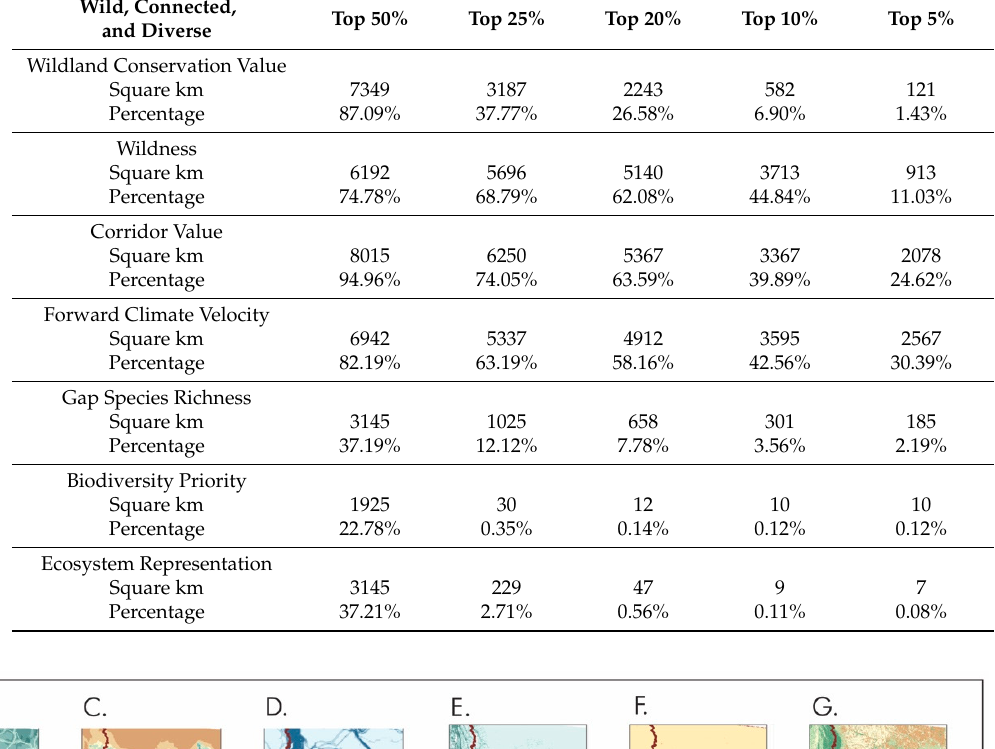
Table 3. The conservation values of the Continental Divide Trail corridor.